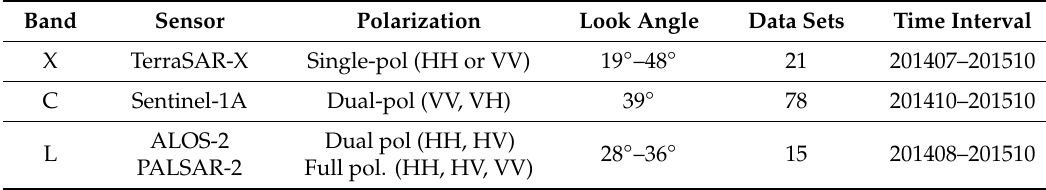
Table 2. SAR dataset covering the test site of Krycklan.